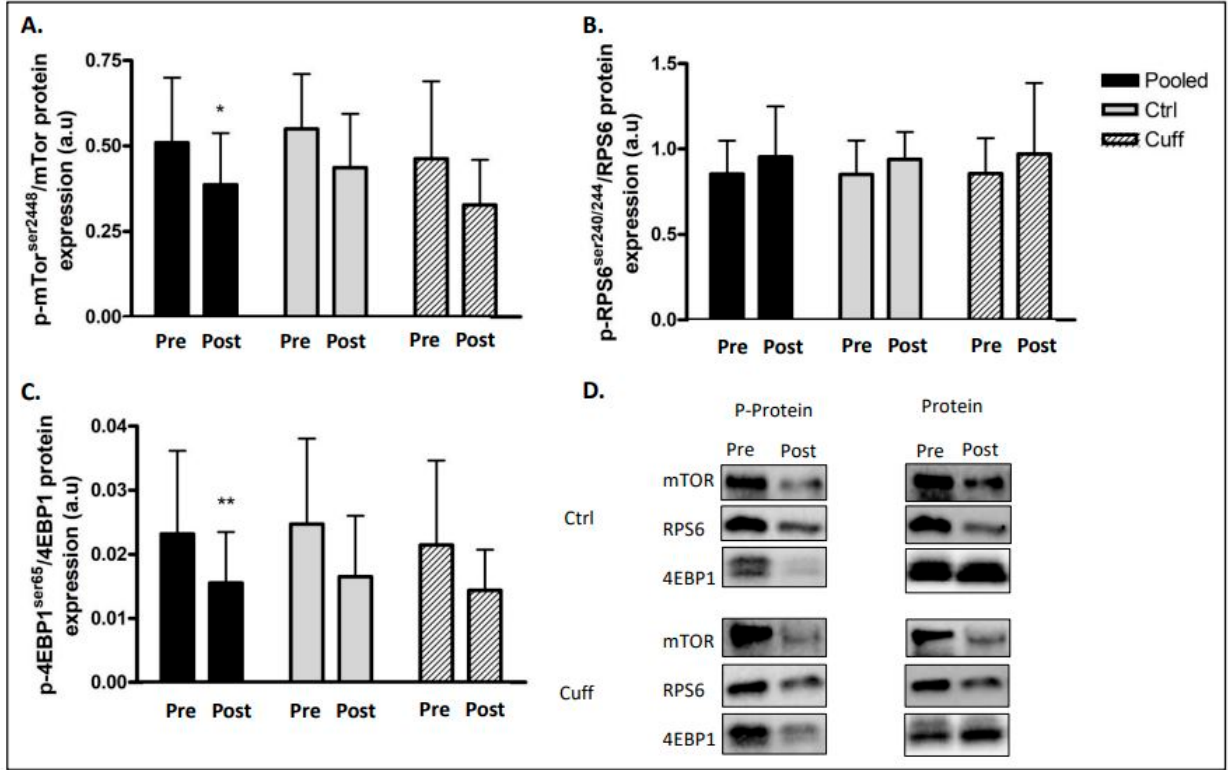
Figure 4. Effect of 5 days of DI on protein synthesis marker. Protein synthesis marker activation access by western blot analysis. ( A ) p-mTor ser2448 /mTor protein ratio. ( B ) p-RPS6 ser240/244 /RPS6 protein ratio. ( C ) p-4EBP1 ser65 /4EBP1 protein ratio. ( D ) Western blot picture analyzed by groups. * different from pre value in the same group. * p < 0.05; ** p < 0.01.